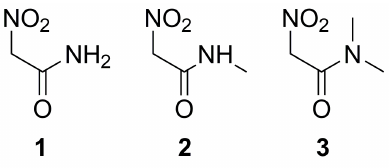
Figure 2. Nitroacetamides studied in this